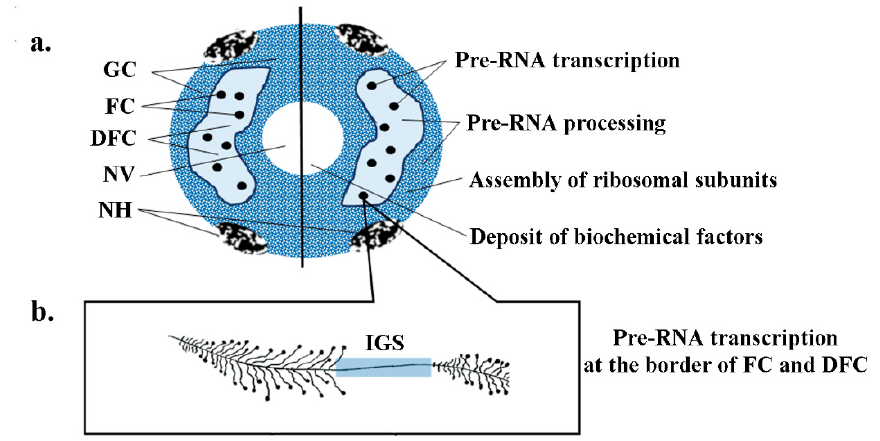
Figure 1. General scheme of the nucleolus and the local regions of plant rRNA transcription: ( a ) nucleolus structure (GC, granular component; FC, fibrillar center DFC, dense fibrillar component; NV, nucleolar pseudo-vacuole; and NH, nucleolus-associated heterochromatin); and ( b ) ribosomal DNA with multiple transcription sites and intergenic spacer (gray).